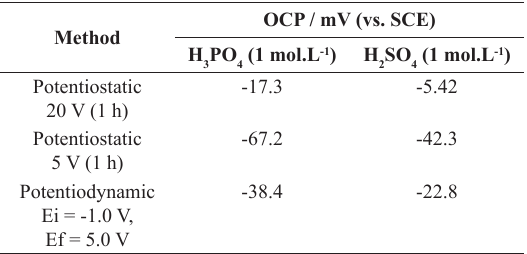
Figure 5. XPS spectra for tantalum, oxygen and phosphorus of the sample of tantalum oxide obtained in H Table 1. OCP values for tantalum oxides grown by potentiostatic and potentiodynamic methods in H